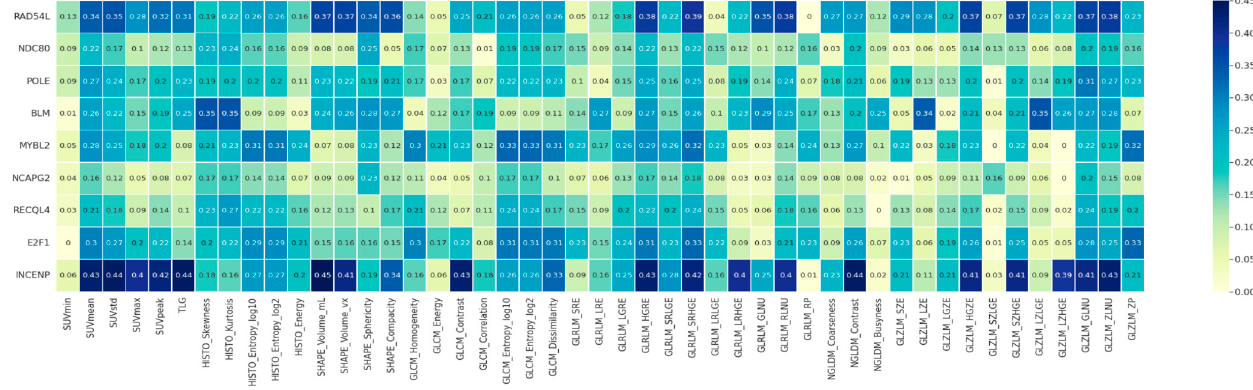
Figure 3. Correlation map of image texture features and functional genes revealing significant associations between 47 image texture features from PET and the 9 hub genes identified by functional analysis.